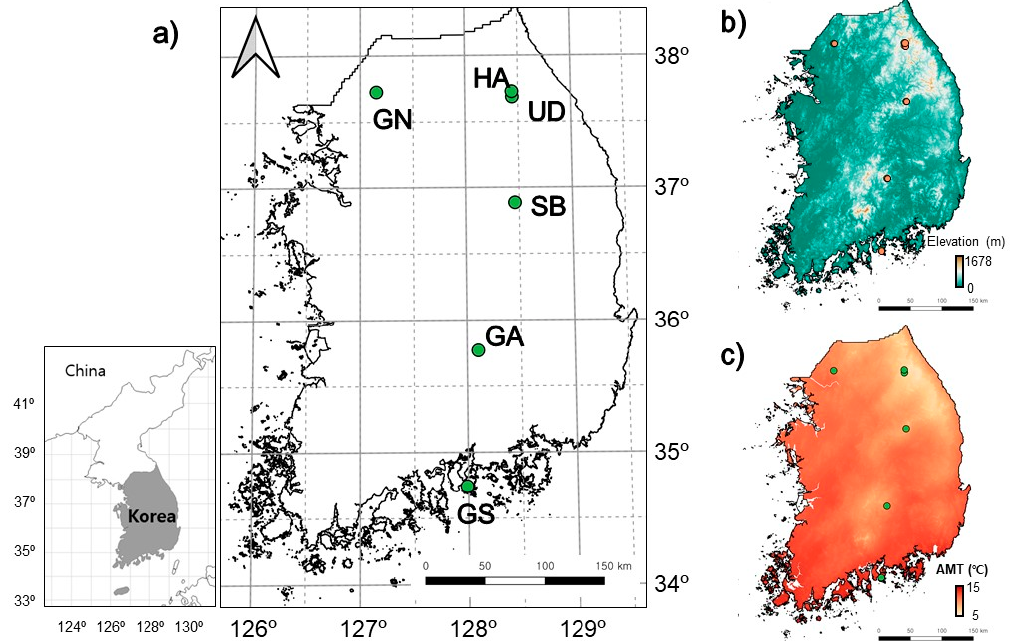
Figure 1. Study sites ( a ) and environmental conditions: elevation ( b ) and annual mean temperature (ATM) ( c ). UD: Unduryong, HA: Haanrim, GN: Gwangneung, SB: Sobaeksan, GA: Gayasan, and GS: Geumsan.